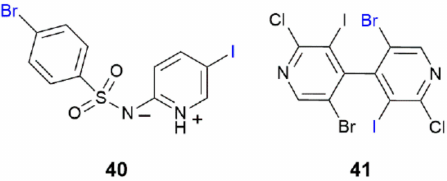
Figure 10. Chemical diagrams for molecules that form I · · · Br interactions in their crystals leading to two- and three-dimensional aggregation patterns ( 40 and 41